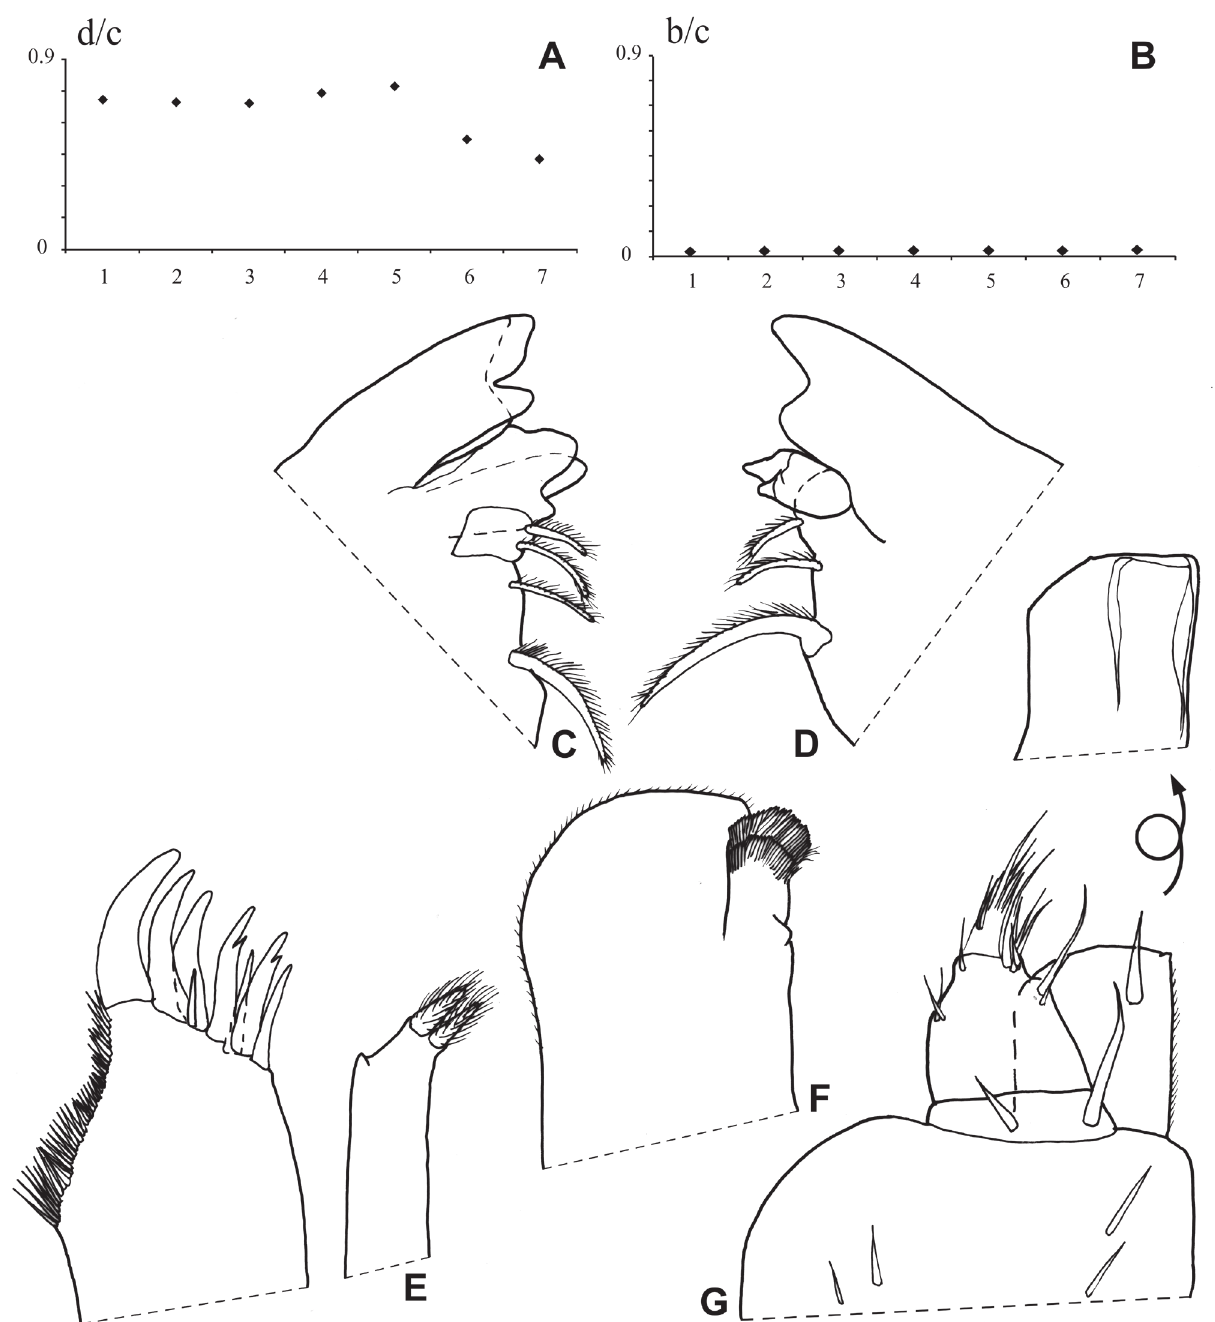
Figure 9. Trichorhina cipoensis n. sp. (male paratype). A, d/c coordinates of noduli laterales ; B, b/c coordinates of noduli laterales; C, left mandible; D, right mandible; E, maxillula; F, maxilla; G,